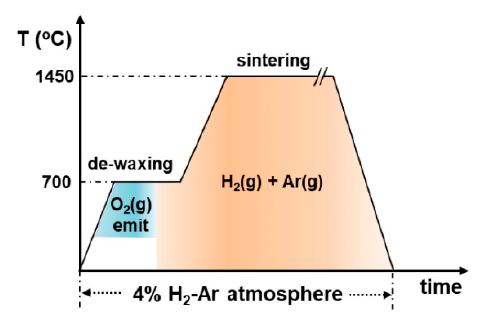
Figure 4. Thermal profile of the sintering process in the head-end of pyroprocessing.